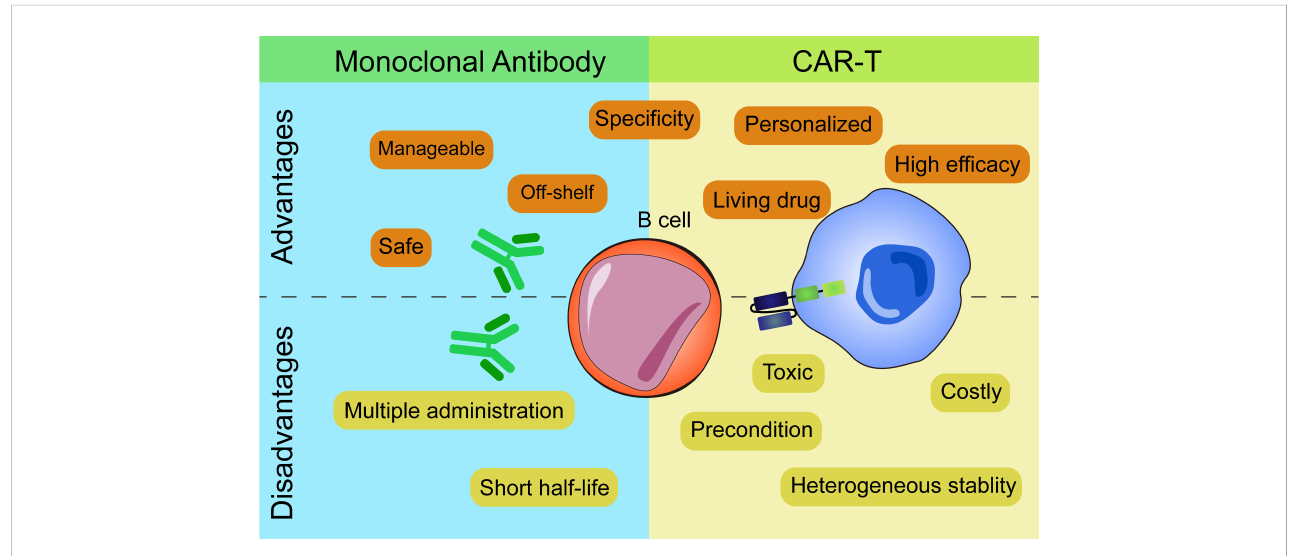
FIGURE 2 Advantages and disadvantages of mAbs and CAR-based